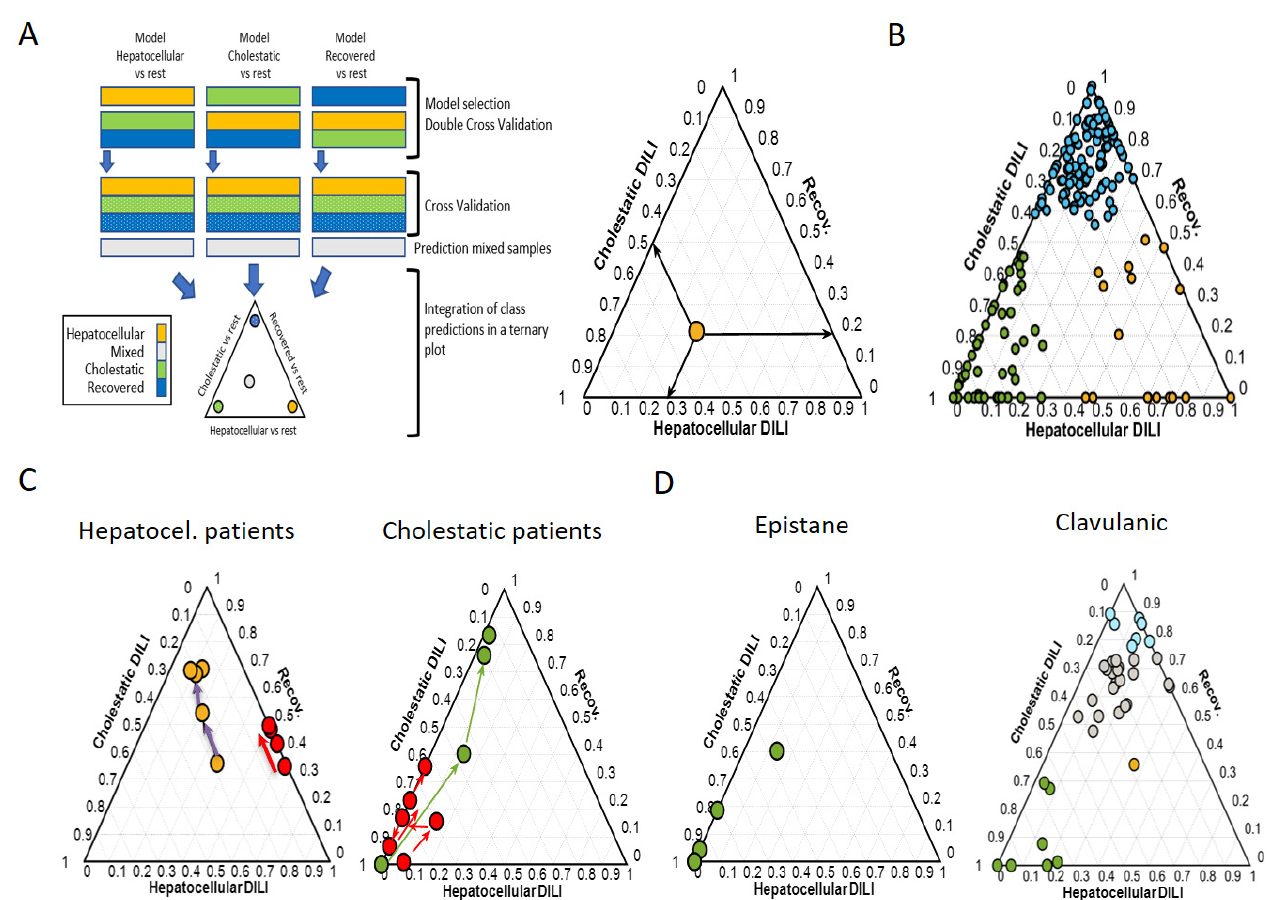
Figure 4. Schematic workflow of data analysis and modelling strategy to represent and interpret data in a ternary plot. ( A ) First, a PLS–DA analysis of each phenotype (hepatocellular DILI, cholestatic DILI and recovered patients) vs. the rest was carried out using the complete set of features. The set of y predicted values from the selected models were integrated into a ternary plot. A ternary plot is a two-dimensional graphical representation of three variables that sum to a constant. As PLS–DA “y” predicted values used for sample classification are unbound, “y” predicted values higher than 1 or lower than 0 were replaced by 1 or 0, respectively, and the position within the ternary plot was defined by the relative constrained “y” values. By doing this, the ternary plot was an equilateral triangle with edges to graphically depict the constrained “y”-predicted values for DILI (PLS–DA model: recovered vs. non-recovered), cholestasis (PLS–DA model: cholestasis vs. non-cholestatic), and hepatocellular (PLS–DA model: hepatocellular vs. non-cholestatic) damages. ( B ) Example of a ternary plot used to describe the different phenotypes of DILI (cholestatic, hepatocellular, and mixed, as well as those from recovered patients) predicted using the PLS–DA models. ( C ) Time-course monitoring of two patients initially diagnosed as hepatocellular and mixed-type (left triangle) or pure cholestatic (right triangle) DILI, and their evolution along the time course of the disease. While in some cases there is a clear improvement towards recovery (yellow and green dots), in others the situation worsened (red dots). ( D ) Not always that a given drug displays the same DILI phenotype in all patients. A given drug may or may not display the same DILI phenotype in all patients. While in the case of epistane all patients consistently displayed a cholestatic pattern (left triangle), in the case of clavulanic acid a wide range of mixed type DILI was observed (right panel). Dot colour represents the clinical classification at each point: green: cholestatic DILI; orange: hepatocellular DILI; gray: mixed DILI; blue: recovered patient (colour figure online). Panel A was obtained from [92].